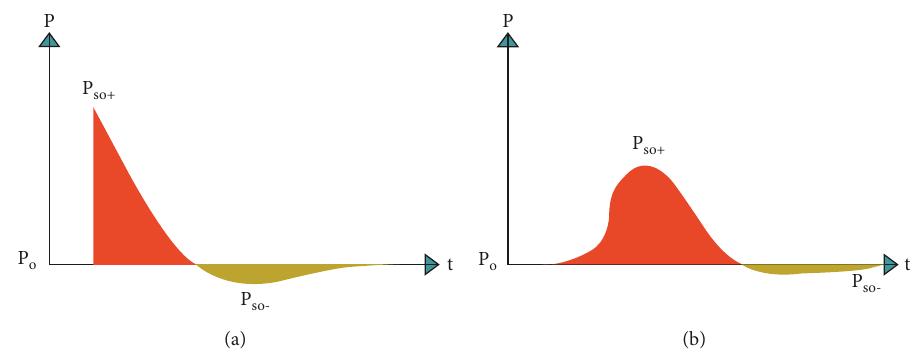
Figure 1: Range of strain rate for different type dynamic loading.